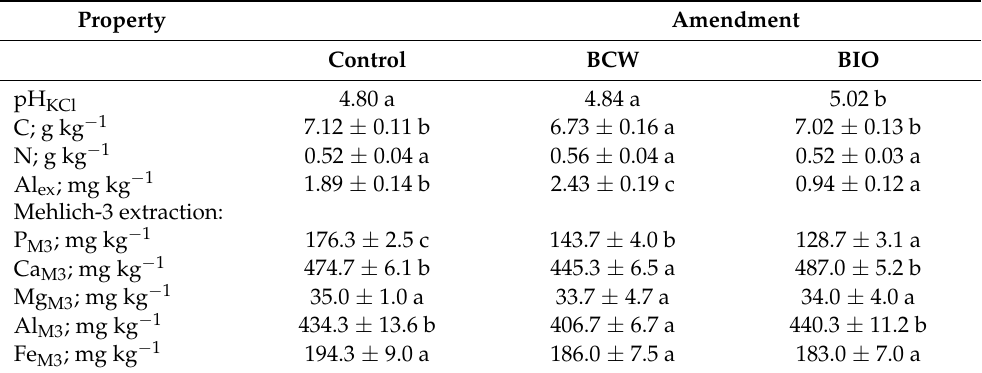
Table 3. Properties of soil after application of amendments: brown coal waste (BCW) and conifer woodchip biochar (BIO) in the field experiment compared to the control (mean ± standard deviation, n =